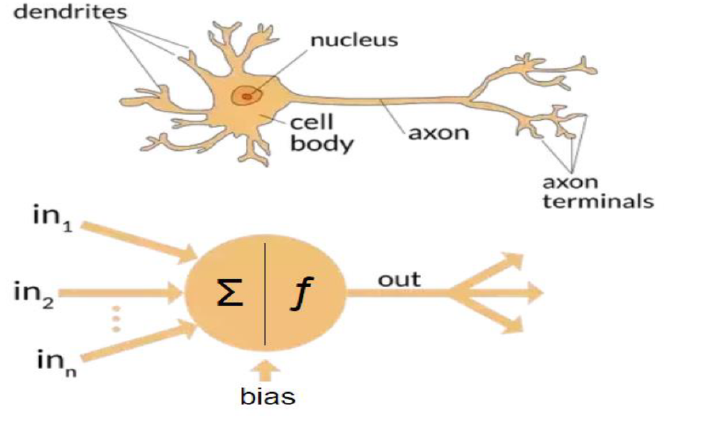
Figure 1. Biological and artificial neuron.